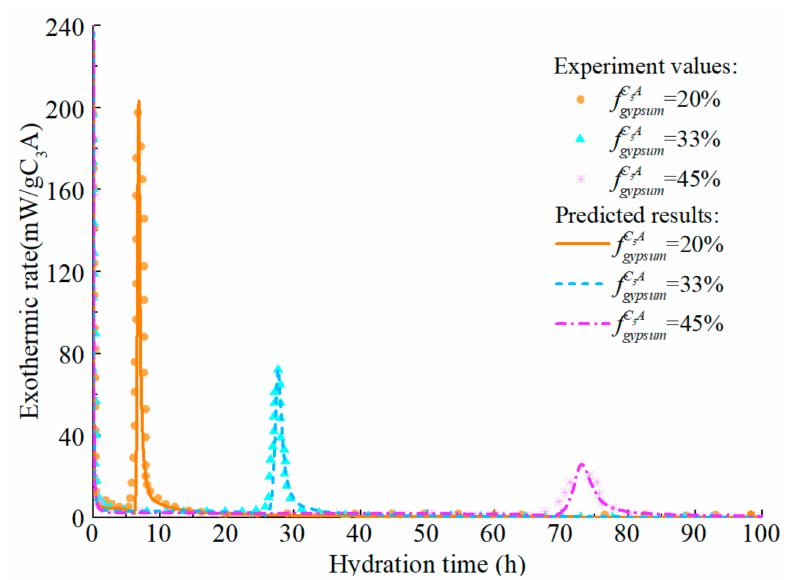
Figure 14. Hydration heat release rate of C 3 A in C 3 A- Gypsum system with different gypsum content (fine particle, w/c = 1.0).